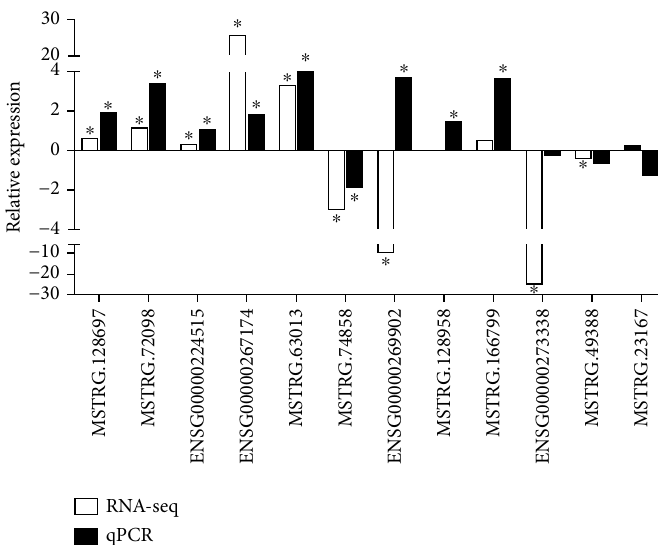
Figure 7: Comparisons of the results between RNA sequencing data and con fi rmation of 12 lncRNAs in the validation cohorts by qPCR. ∗ indicates signi fi cant di ff erence in RNA sequencing data or validation cohorts by qPCR between T1D patients and healthy controls. Table 3: Information of 12 lncRNAs validated with the expanded cohort in the present study and their potential orthologous sequences compared with mouse data.